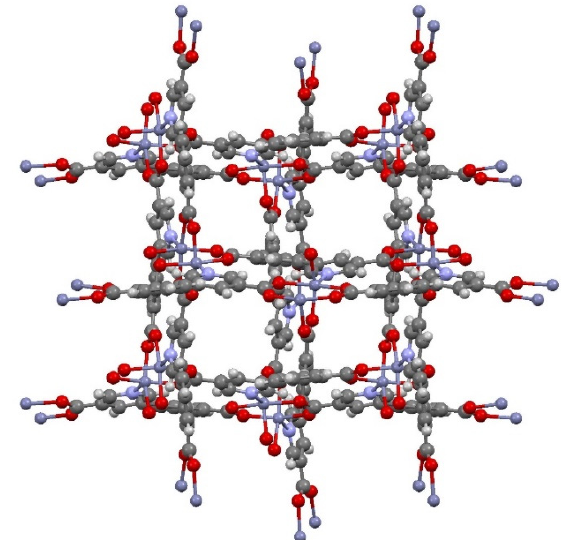
Figure 1. View of the Zn(dcpa) framework along the c-axis (Zn: blue, O: red, C: grey, and H: white). Data generated from the CIF file reported by Liu et al. [34] .